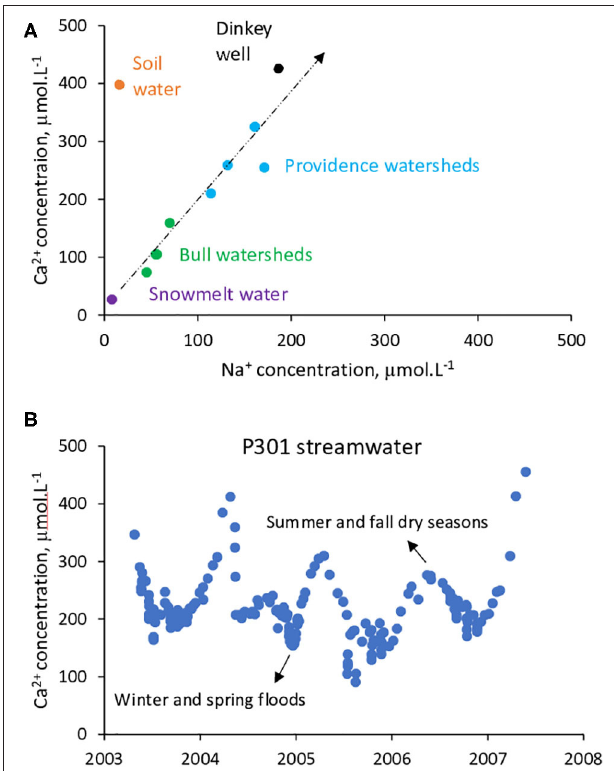
FIGURE 4 | Overview of the chemical variability for Providence and Bull stream waters. (A) Elemental Na + – Ca 2 + diagram with mean annual solute concentrations for Providence and Bull stream waters, snowmelt, soil water and Dinkey well groundwater (4km from Providence). Data from Liu et al. (2013). (B) Seasonal variability of Ca 2 + concentrations for P301 streamwaters. Data are shown for period studied